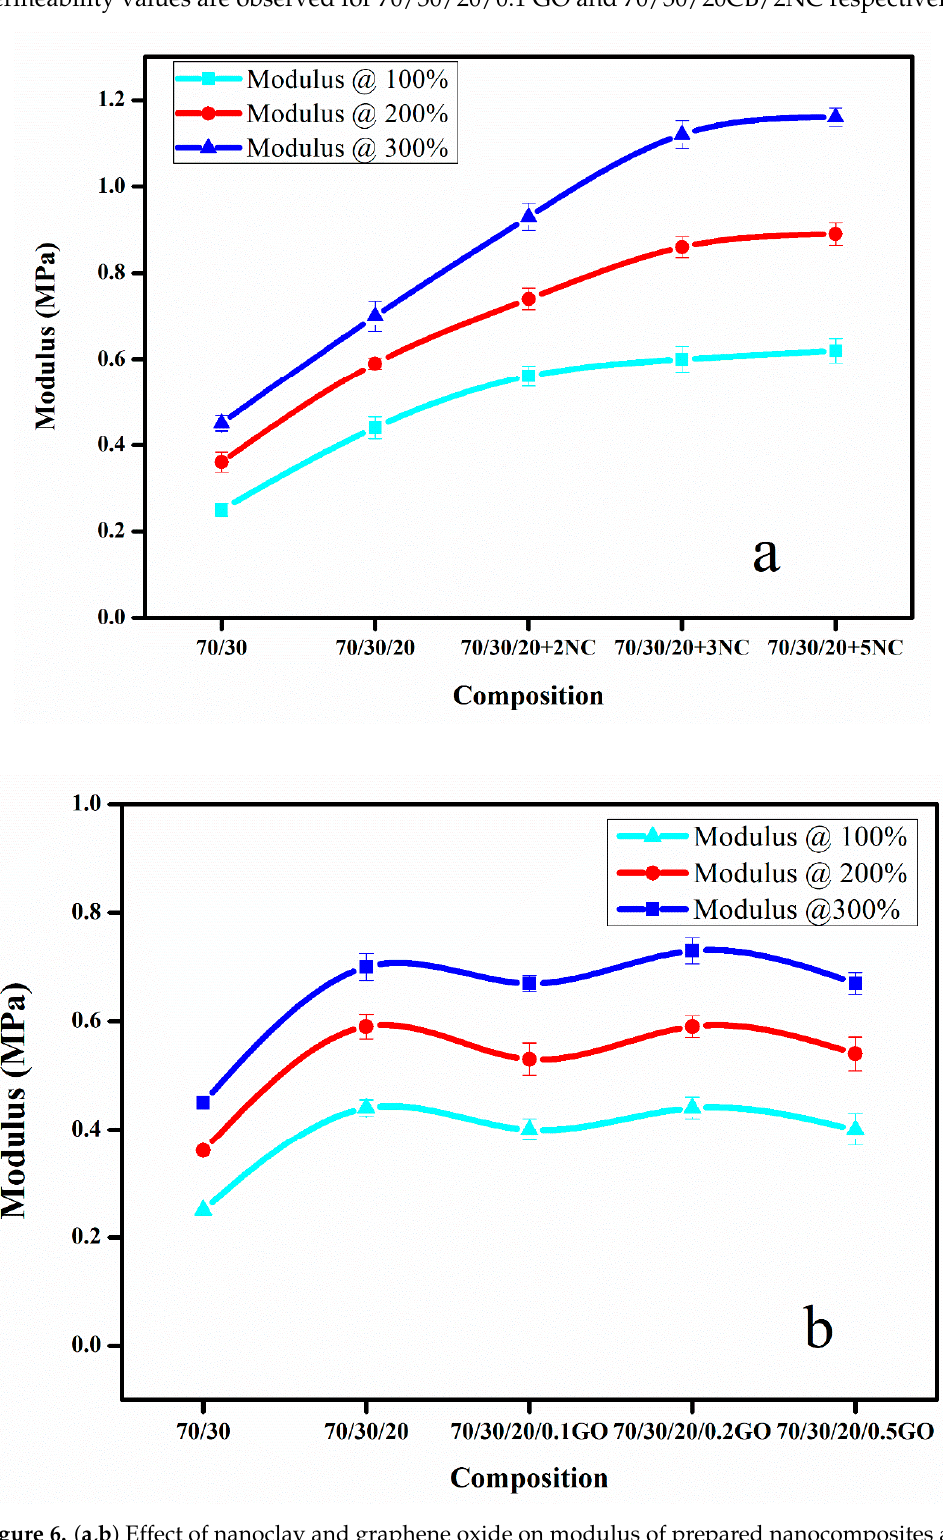
Figure 6. ( a , b ) Effect of nanoclay and graphene oxide on modulus of prepared nanocomposites at 100%, 200% and 300% elongation.